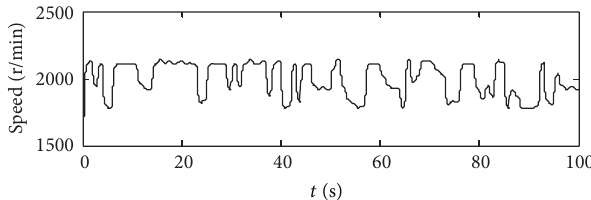
Figure 5: Best values for each iteration.